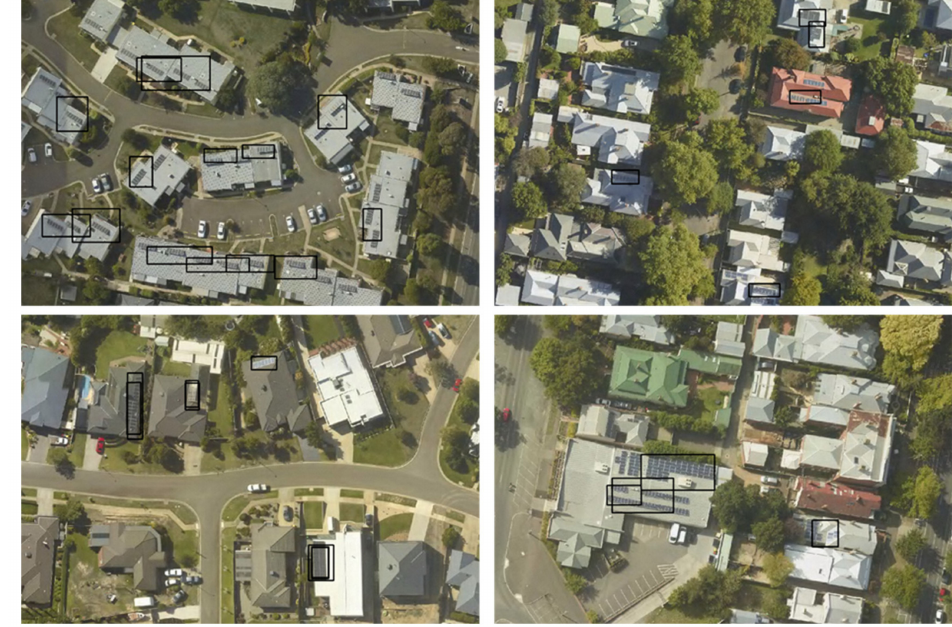
Figure A1. Samples of bounding boxes generated by the model containing the solar